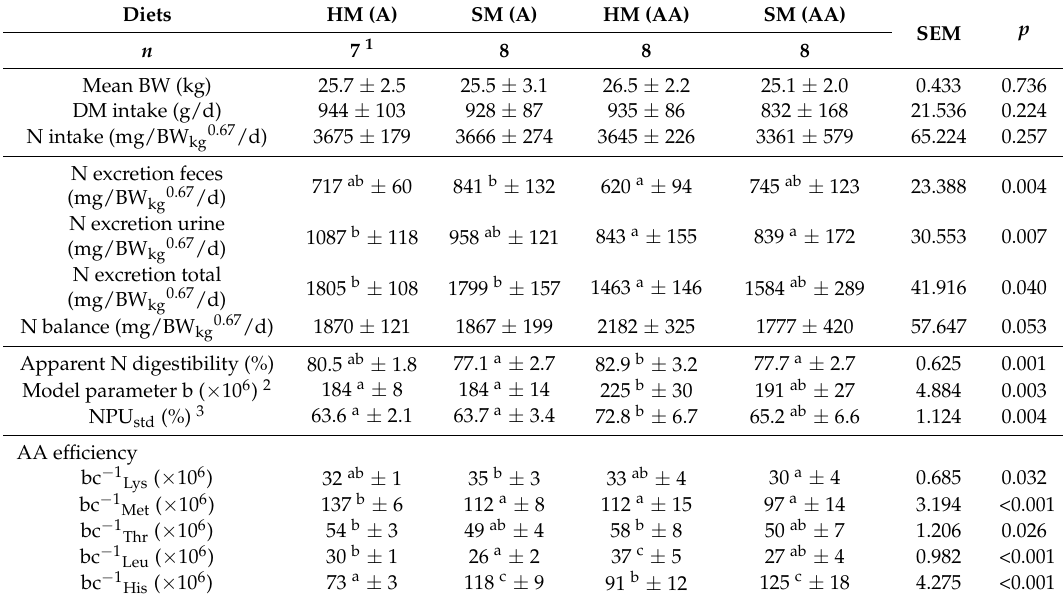
Table 5. Summarized results of the N balance study with piglets (BW 25